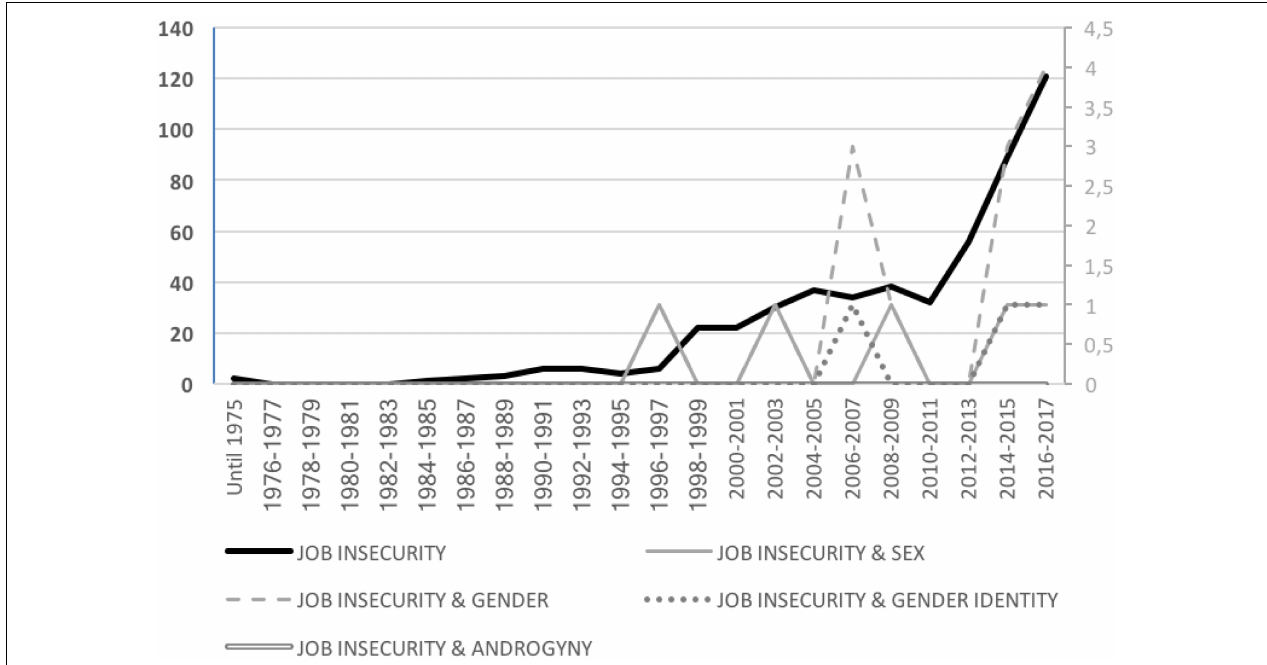
FIGURE 4 | Total number of scientific articles per year about job insecurity by gender